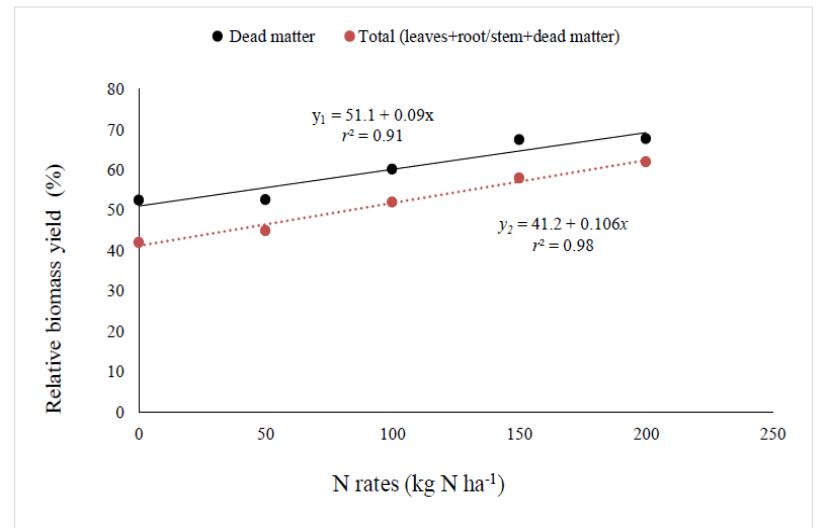
Figure 3. Regression model for relative dead matter (y 1 ) and total biomass yield (leaf + root/stem + dead matter, y 2 ) of swede and kale averaged, affected by different nitrogen (N) rates averaged across three environments in Prosper and Walcott, ND, USA in 2012 and 2014.